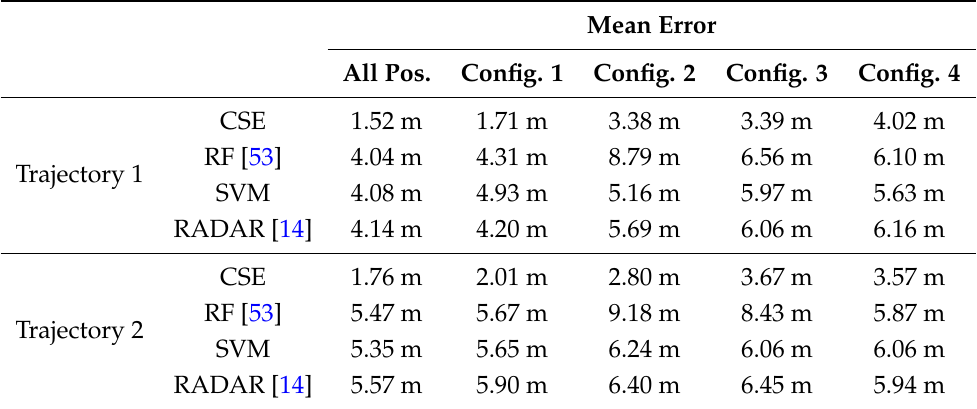
Table 4. Training resolution